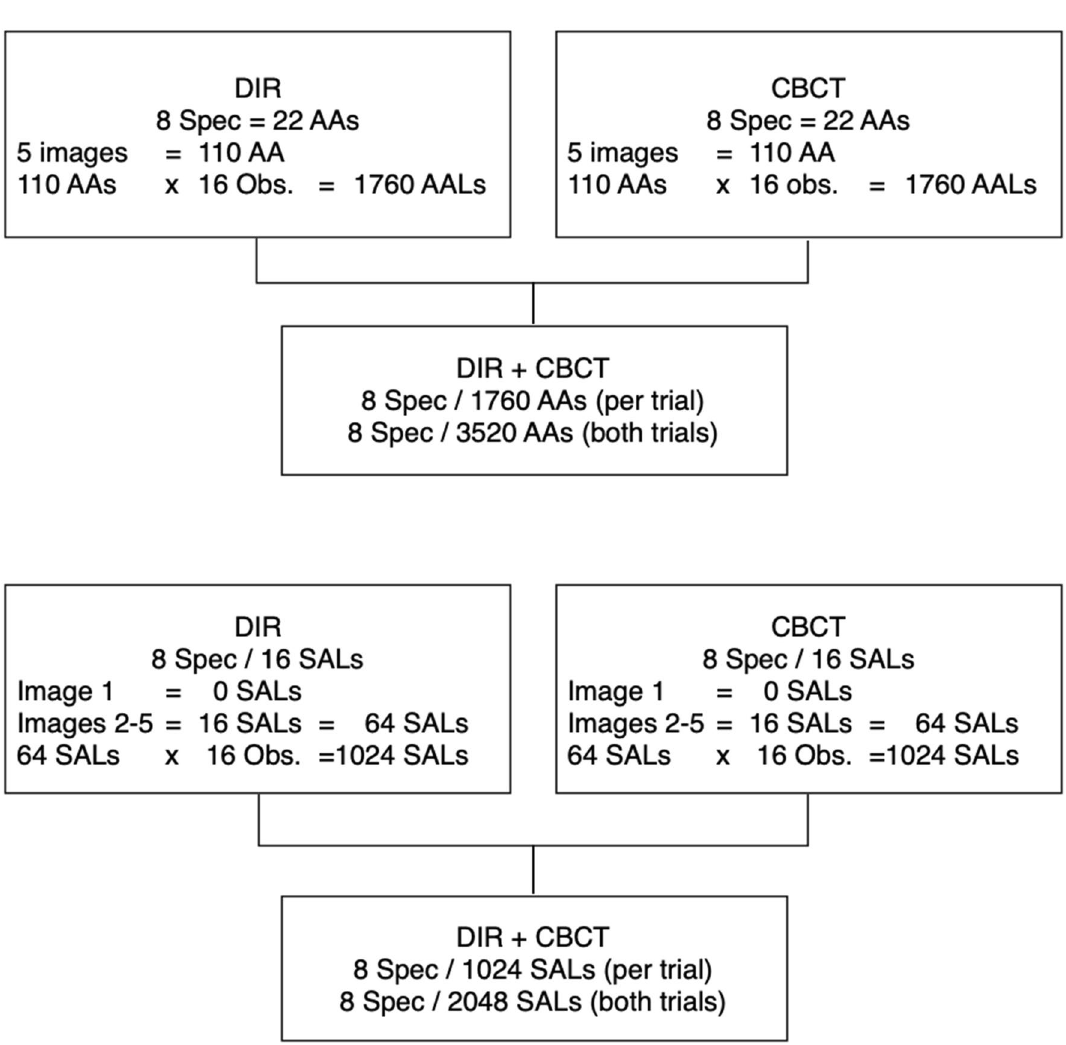
Figure 3. Flow diagram of data of all teeth/roots of the specimens (Spec.) to be diagnosed by means of digital intraoral radiographs (DIR) and cone-beam computed tomography (CBCT) by 16 observers (Obs.) in two observation trials with a 4-week difference time when considering the apical areas (AAs; AALs: apical area lesions) and simulated apical lesions (SALs). Specimen, AAs and Obs. total number determined to be diagnosed with DIR and CBCT (upper part). Specimen, SALs and Obs. total number determined to be diagnosed with DIR and CBCT (lower